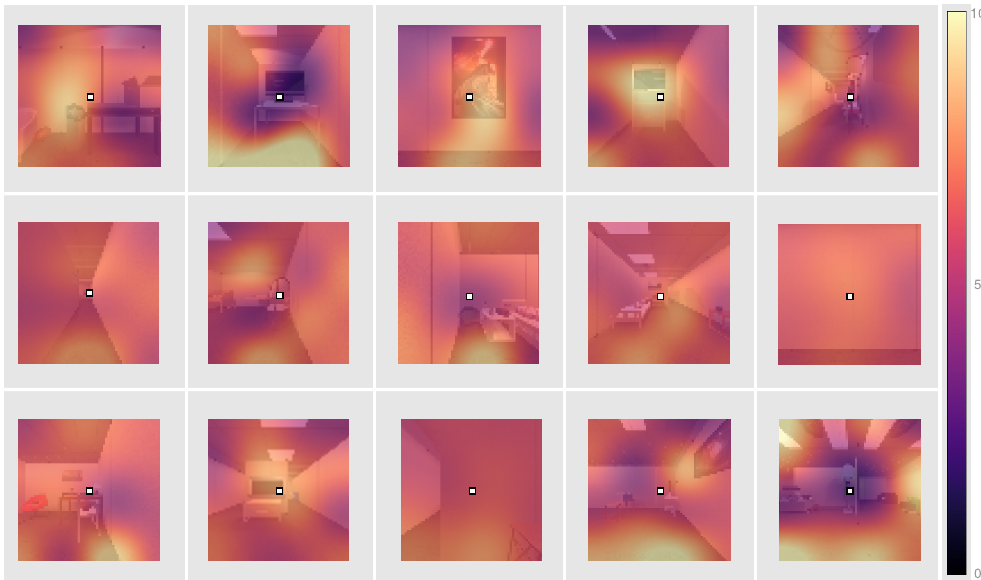
Figure 8. Attention Visualization. Fifteen snapshots are taken from the simulator. The visual central pixel is chosen as the query